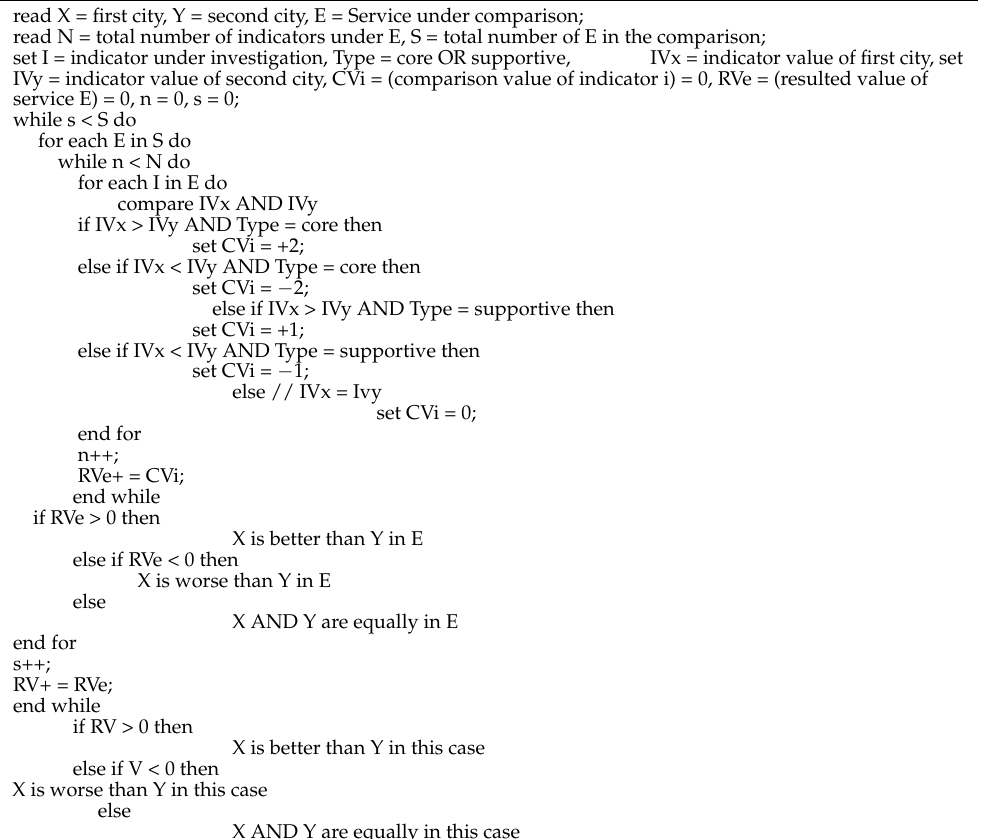
Algorithm 1 Which city has better services towards enhancing